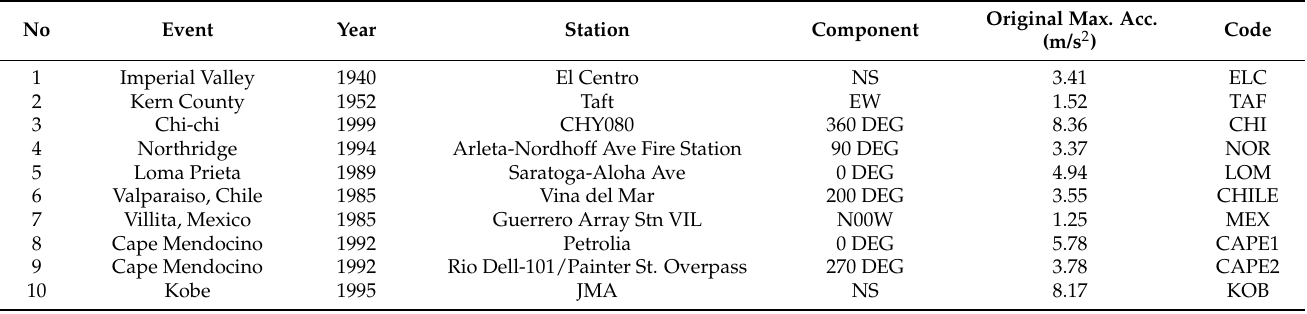
Table 4. List of earthquake ground motions.